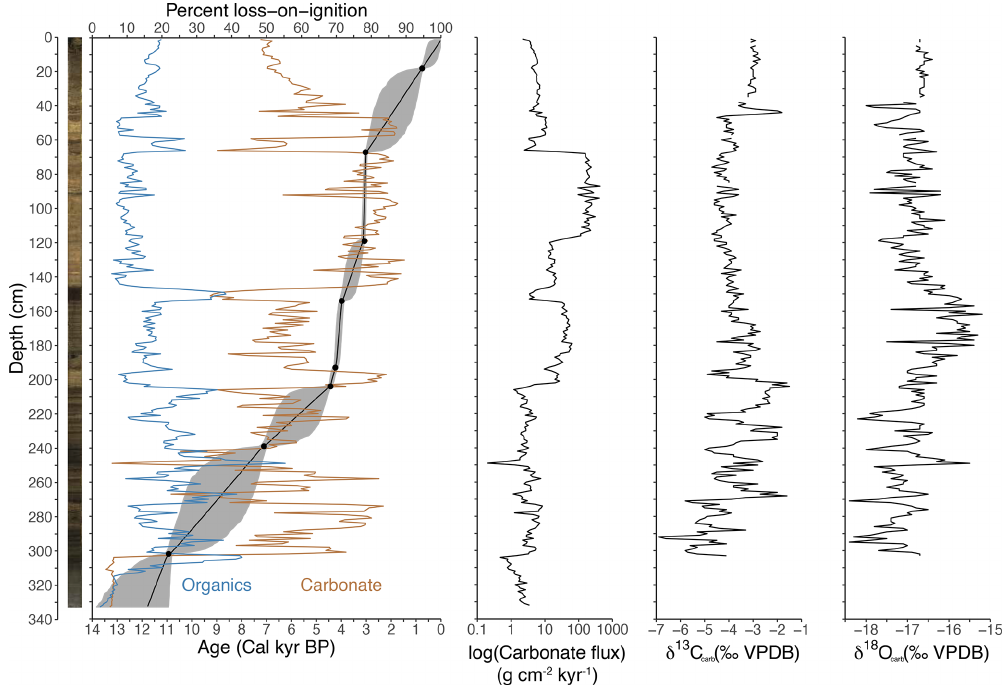
Figure 4. Percent organics, percent carbonate, carbonate flux, δ 13 C carb , and δ 18 O carb are shown by depth alongside an image of the 333cm long sediment core from Highway 130 Lake. Radiocarbon ages (black dots) were used to create the age–depth model and gray uncertainty band (2 σ